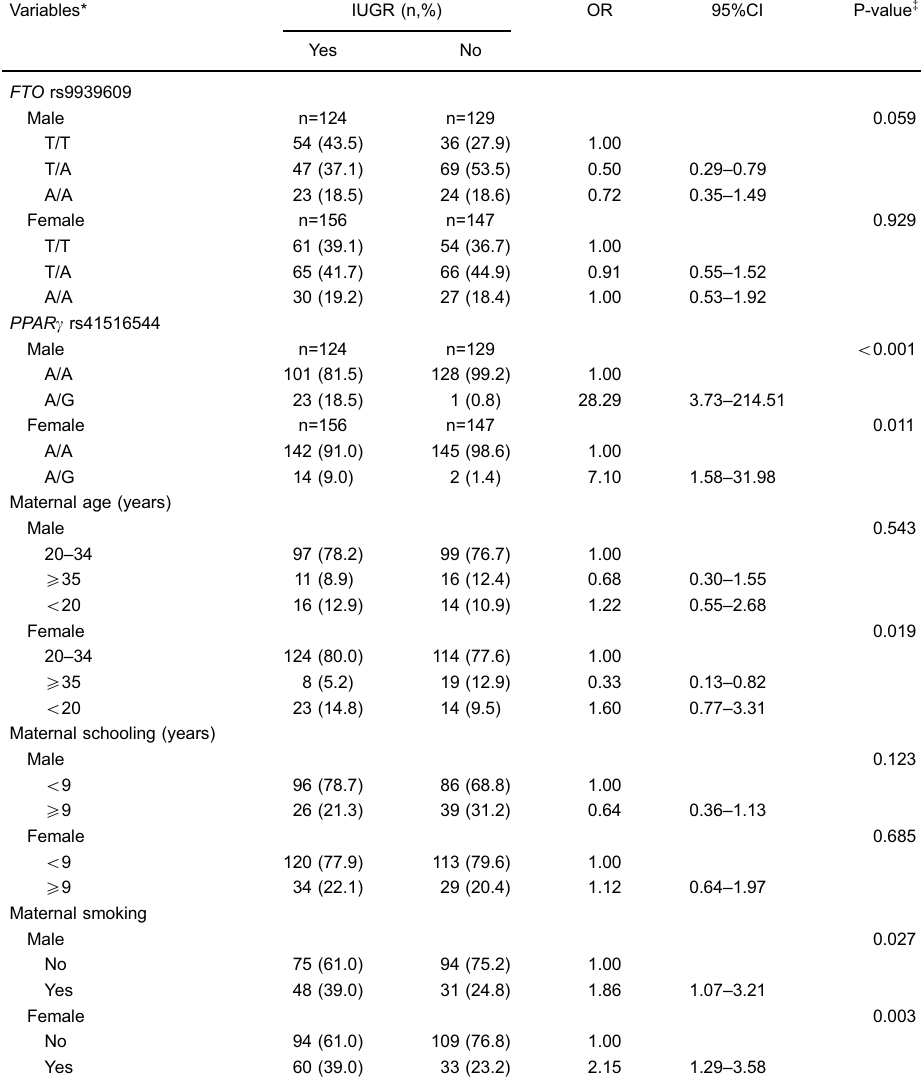
Table 3. Distribution and unadjusted association of genotype and other maternal characteristics with intrauterine growth restriction (IUGR).